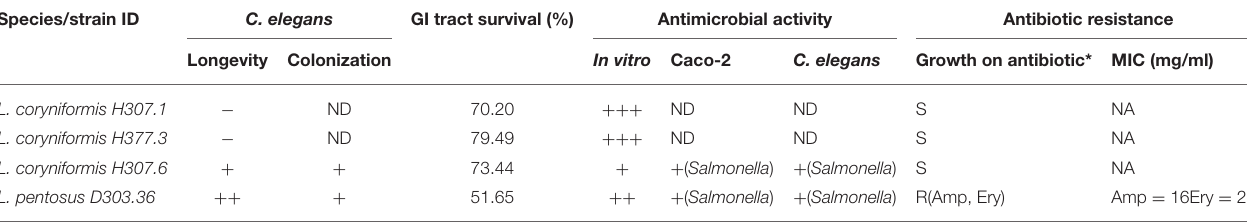
TABLE 5 | Summary table listing the main features displayed by the candidate probiotic strains identified in this study. Species/strain